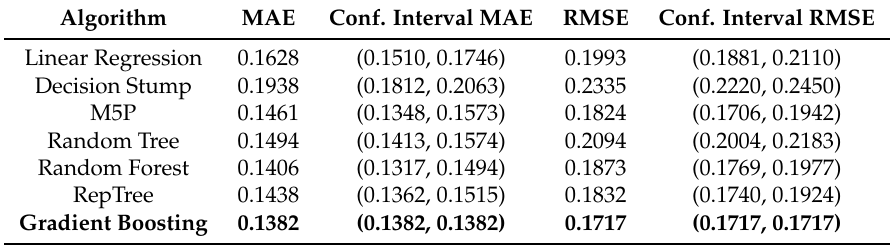
Table 5. Evaluation of ML techniques using the Global Approach: Mean of MAE and RMSE, 99% confidence interval. The best performers are highlighted in bold